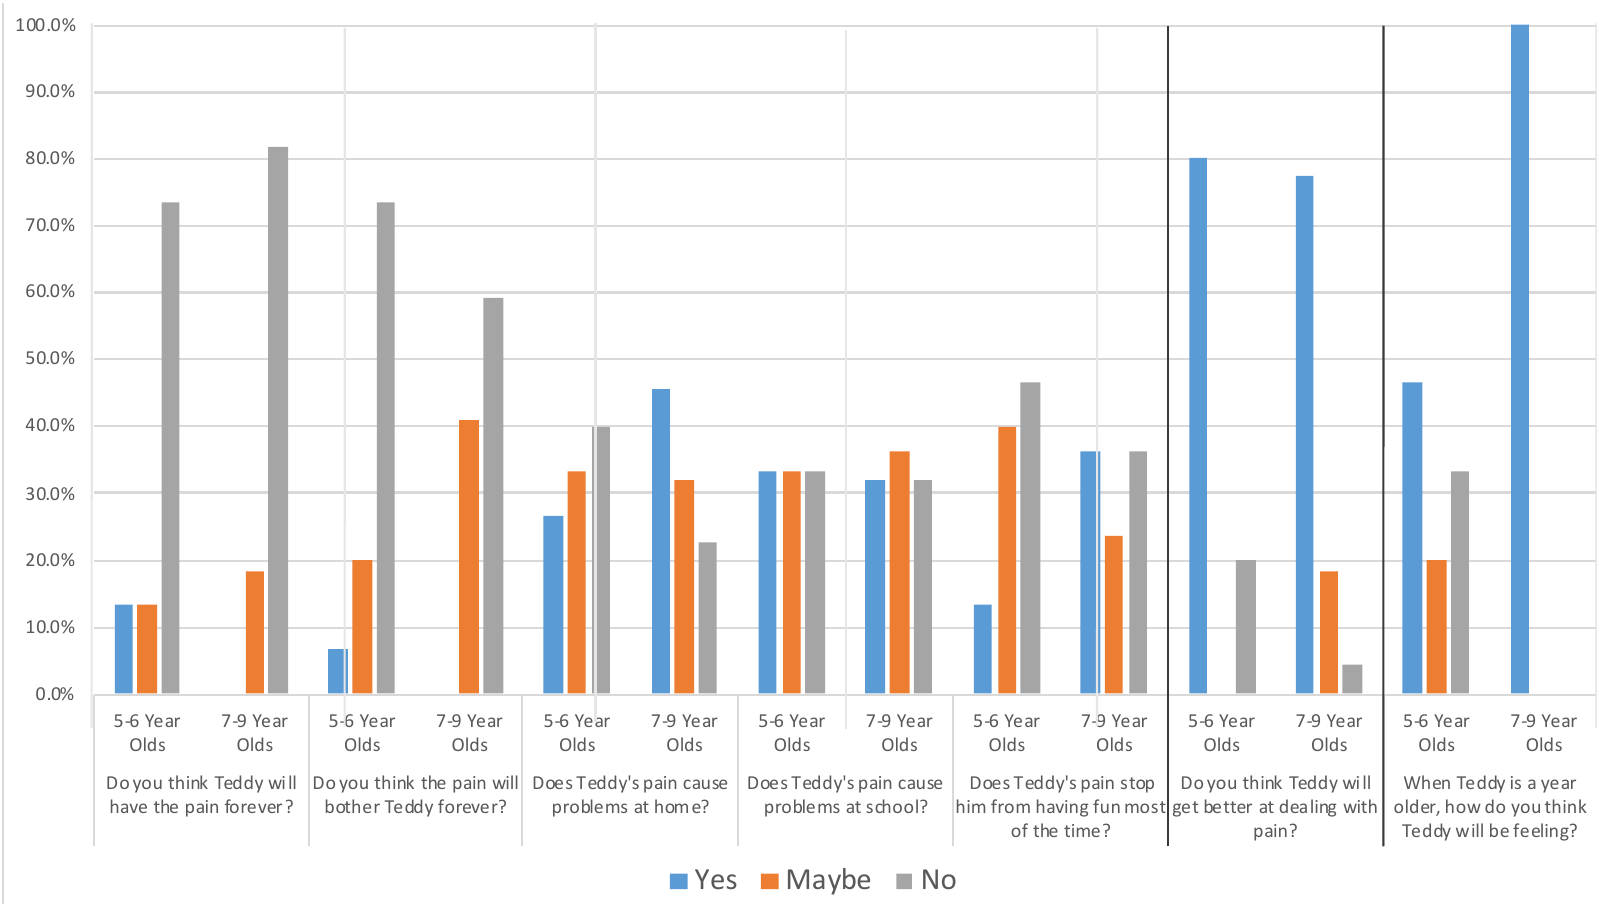
Figure 1. Frequency of Children’s Responses to Teddy Bear Abdominal Pain Interview by Age. Note. For all but one question, bars reflect the percentages of children who responded yes/maybe/no to each question asked by the interviewer. For the question “When Teddy is a year older, how do you think Teddy will be feeling?”, blue bars reflected “better,” orange “the same,” and gray “worse.” The heavy lines are used to highlight that the question second from the right was worded in the opposite direction relative to the questions to the left: lower scores are more positive, and the question furthest to the right had different responses.